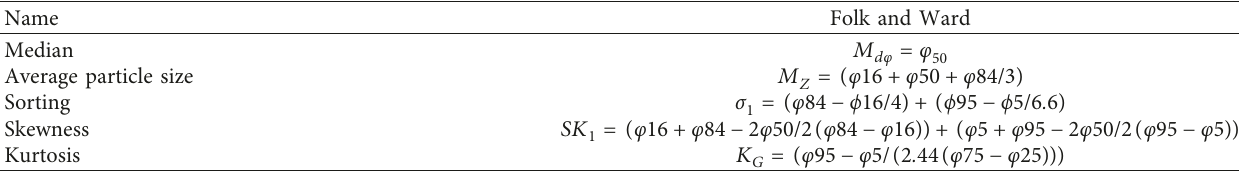
Table 2: Particle size parameter formula.